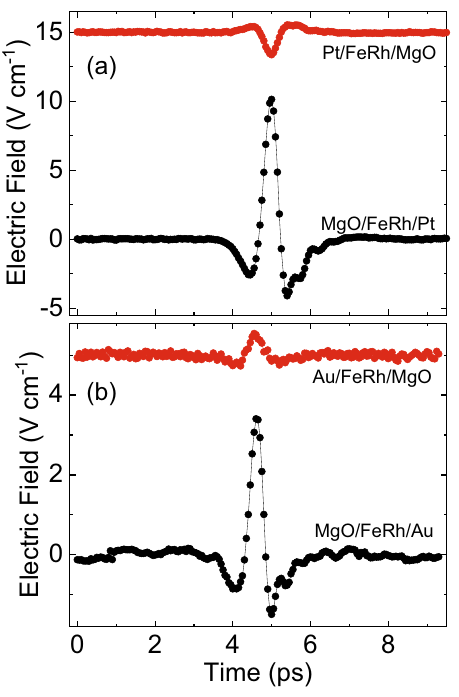
Fig. 6 Single pump THz emission from MgO/FeRh/Pt and MgO/FeRh/ Au. Comparison of the single-pump THz emission in MgO/FeRh/Pt ( a ) and MgO/FeRh/Au ( b ). The measurements were performed at 400K and μ 120 mT. pumping either from the MgO- (black) or Pt(or Au)-(red) side. the magnetic dipole contribution. For MgO/FeRh/Au, the THz signal does not change sign under space inversion (see Fig. 6b).